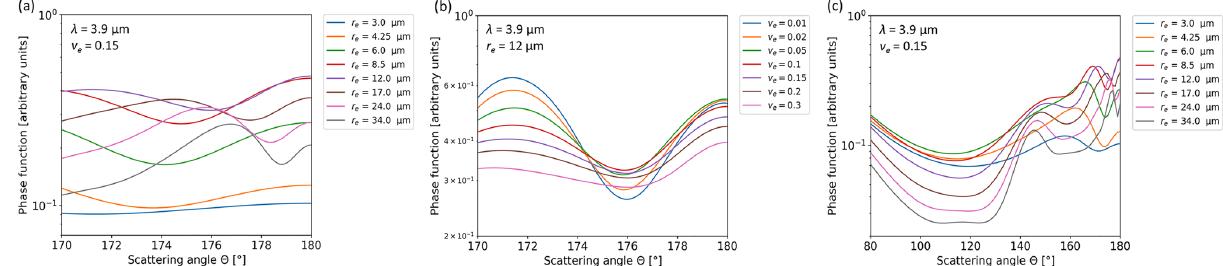
Figure 11. Dependence of the scattering phase functions at 3.9µm wavelength on r e and ν e . (a) Phase functions in the backscattering directions for the eight r e values of the LUTs„ assuming ν e = 0 . 15. (b) Phase functions for the seven ν e values considered, assuming r e = 12µm. (c) As in (a) but for the scattering angle range 80–180 ◦